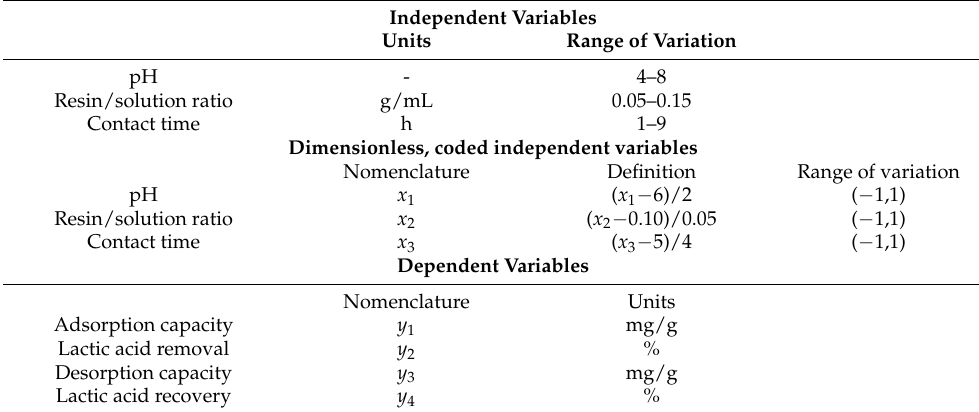
Table 2. Independent and dependent variables used in the Box–Behnken factorial